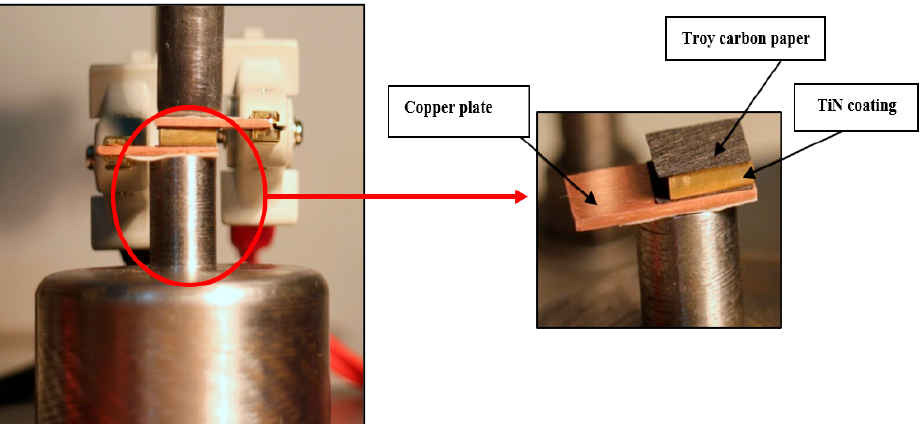
Figure 3. The experimental setup for the ICR measurement [23].